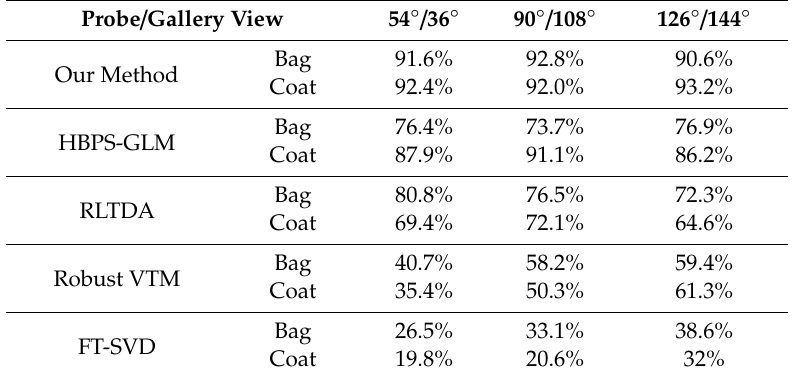
Table 4. Rank-1 recognition rates on the CASIA B gait dataset.